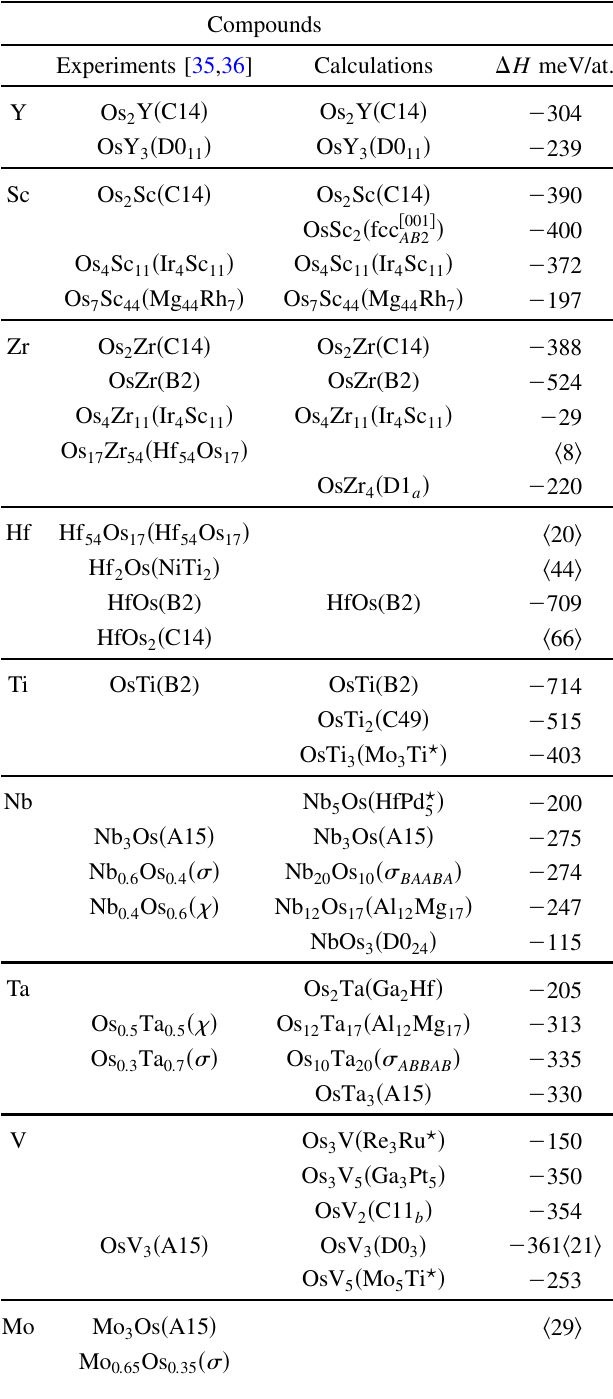
TABLE I. Compounds observed in experiments or predicted by ab initio calculations in Osmium binary alloys (structure prototype in parentheses; multiple entries denote different re- ported structures in the experiments or degenerate structures in the calculations). The ‘‘ (cid:6) (cid:6) (cid:6) ’’ denotes no compounds. The super- script ‘‘ ? ’’ denotes unobserved prototypes found in calculations [2,13,25,27,29,31]. (cid:1) H are the formation enthalpies from the present study. The energy difference between reported and calculated structures or between the reported structure (unstable in the calculation) and a two-phase tieline is indicated as h(cid:6)i . Compounds Experiments